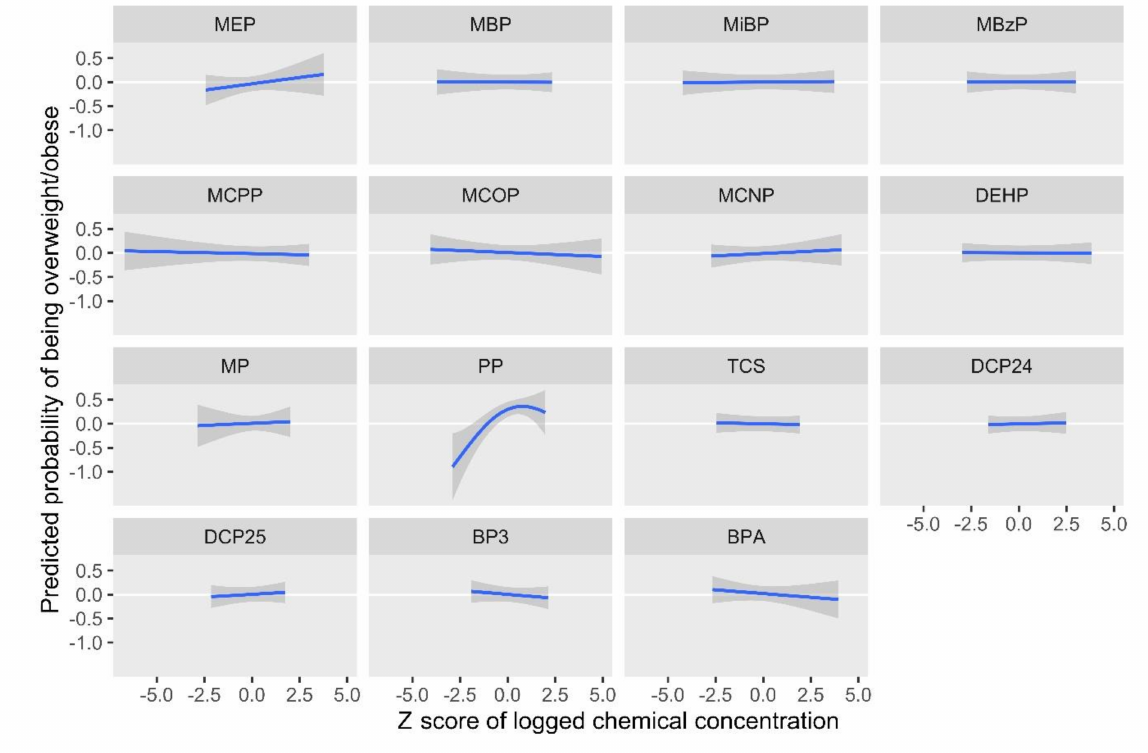
Figure 4. Predicted probability of being overweight/obese by log2 biomarker concentration z -scores, holding all other biomarkers at their